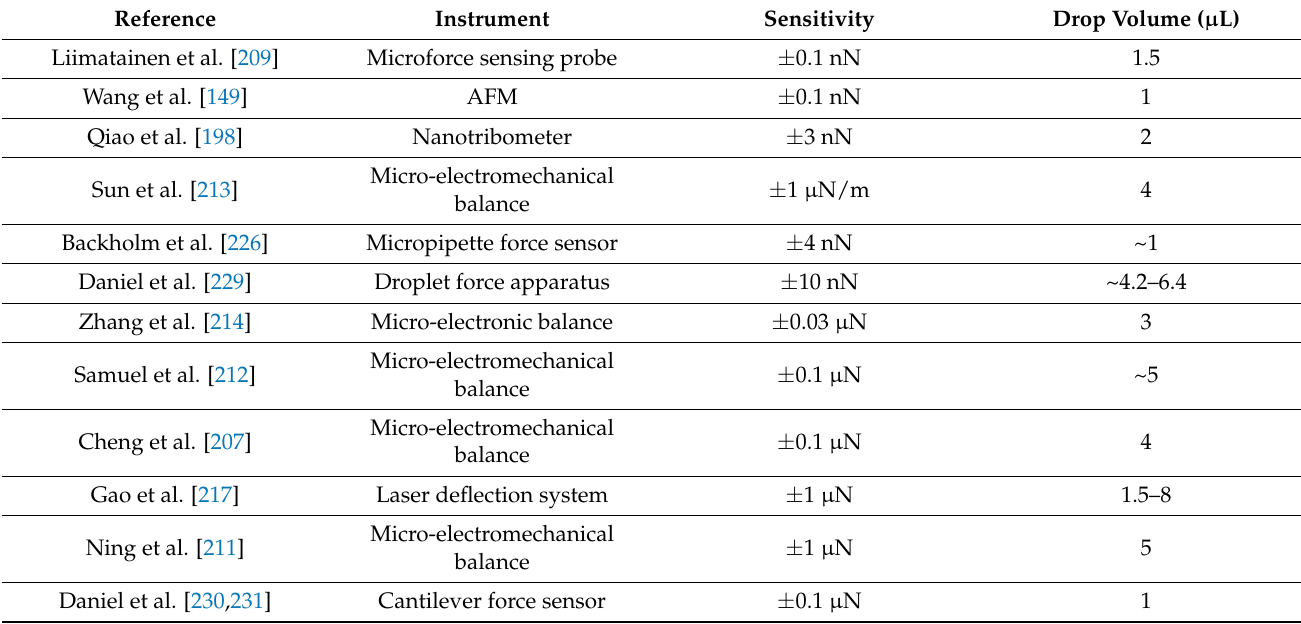
Table 3. List of techniques, reported sensitivities, and typical drop volumes used in the